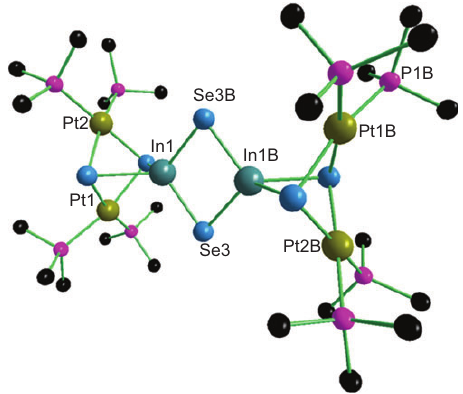
Figure 4 Molecular structure of [ { (PPh et al., 2002). Phenyl groups are omitted for clarity.